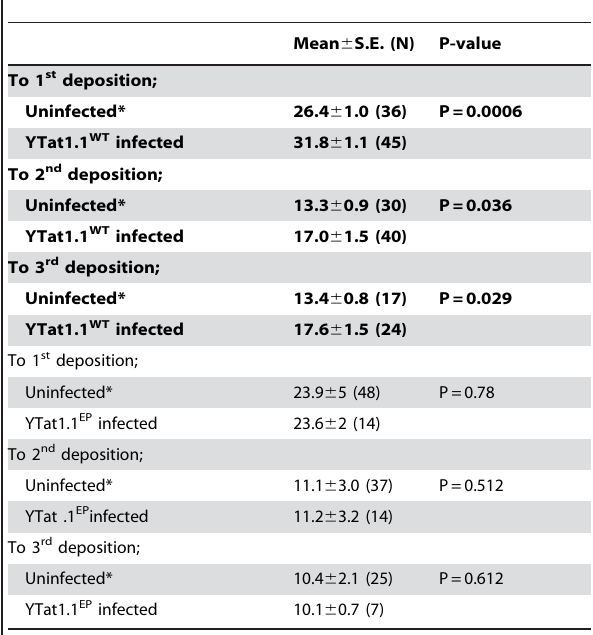
Table 2. Larval deposition intervals of YTat1.1 WT (bold) and YTat1.1 EP infected and uninfected